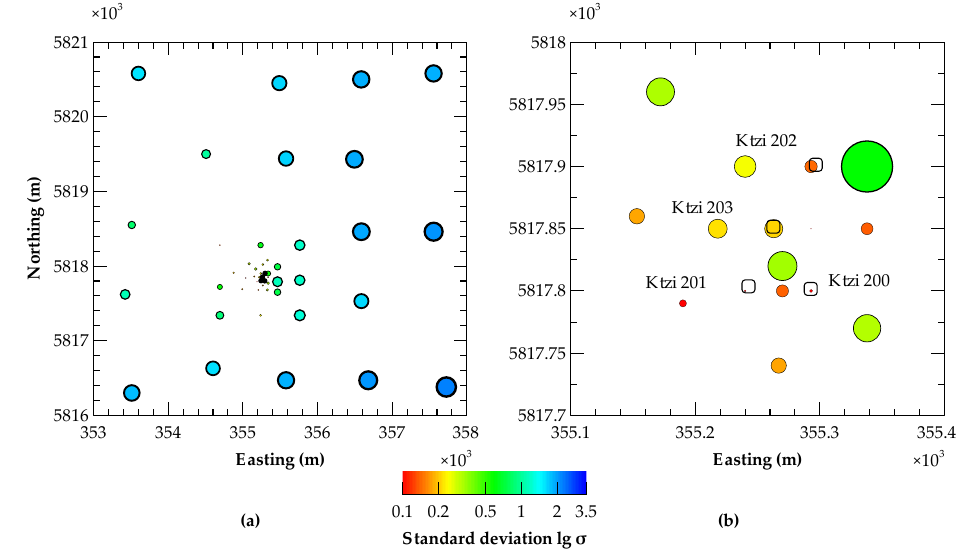
Figure 9. ( a ) Parameter uncertainty at pilot point locations in the calibrated model far-field ( b ) and near-well area, expressed by standard deviation lg σ . Initial standard deviations were defined to lg σ = 3.5 at all 52 pilot points. Empty rounded squares represent well locations. Other circle sizes correlate with calculated standard deviation values independently for each figure (UTM-WGS84